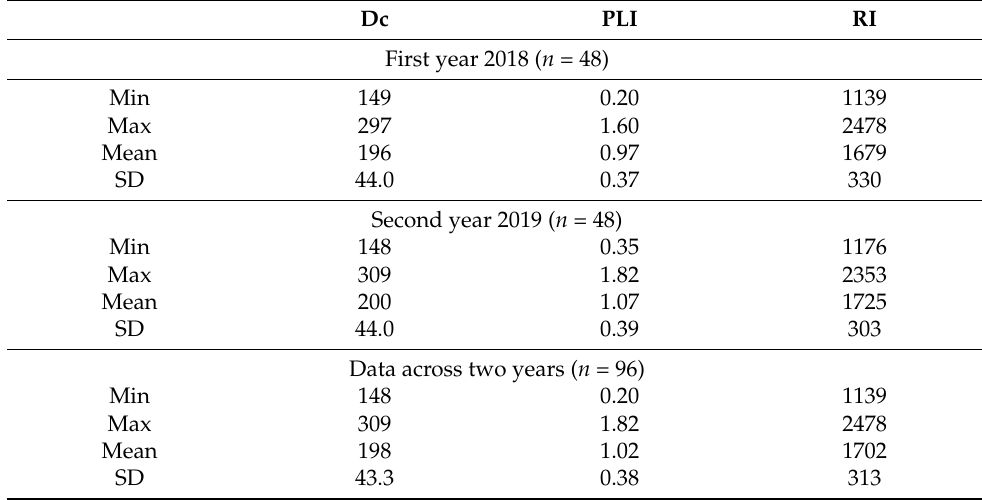
Table 6. Statistical description of the degree of contamination (Dc), pollution load index (PLI), and potential ecological risk index (RI) in Qaroun Lake sediment over two years.